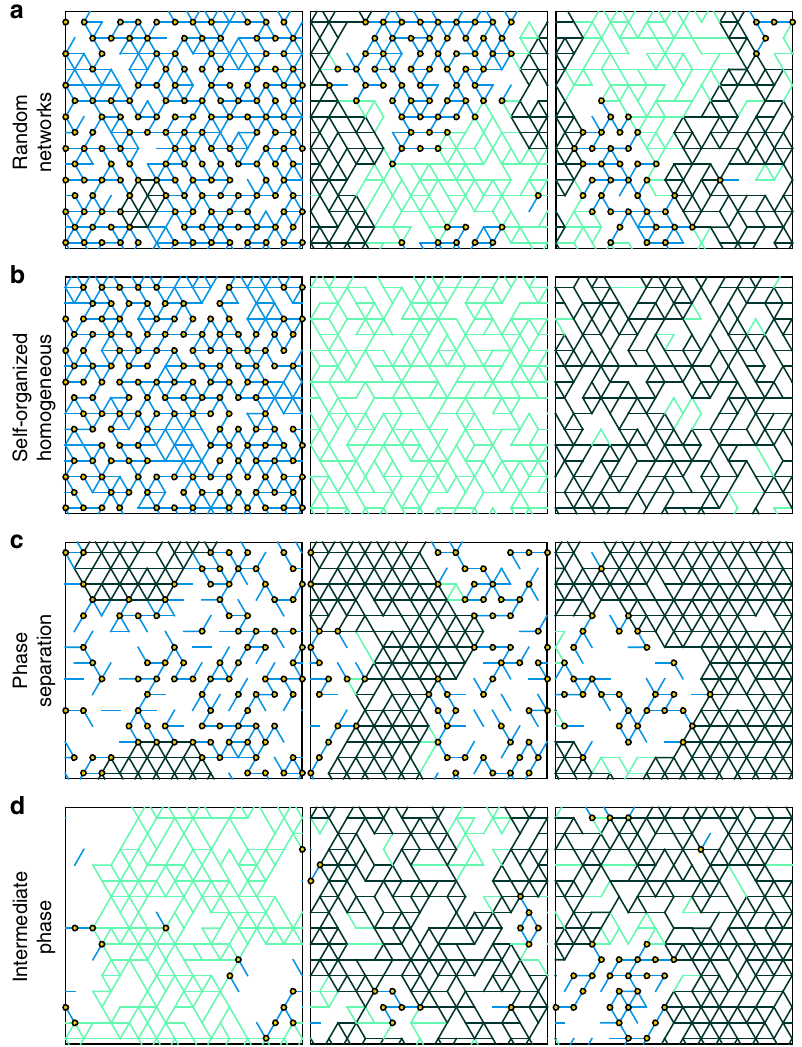
Fig. 1 Scenarios of rigidity transition in elastic networks. Typical structures for a random networks, b self-organized networks, c entropy-favored networks, and d equilibrated networks at T g . From left to right, are structures below, at, and above the rigidity transition threshold. For illustration, we implement the pebble game algorithm 20, 46 to decompose the networks into irreducible rigid clusters, unstressed (blue and green) and stressed (dark green), which are connected by pivots 47 , shown as yellow circles. The connections in the percolating cluster are colored in green (light and dark) and the remainder clusters making the fl oppy regions are in